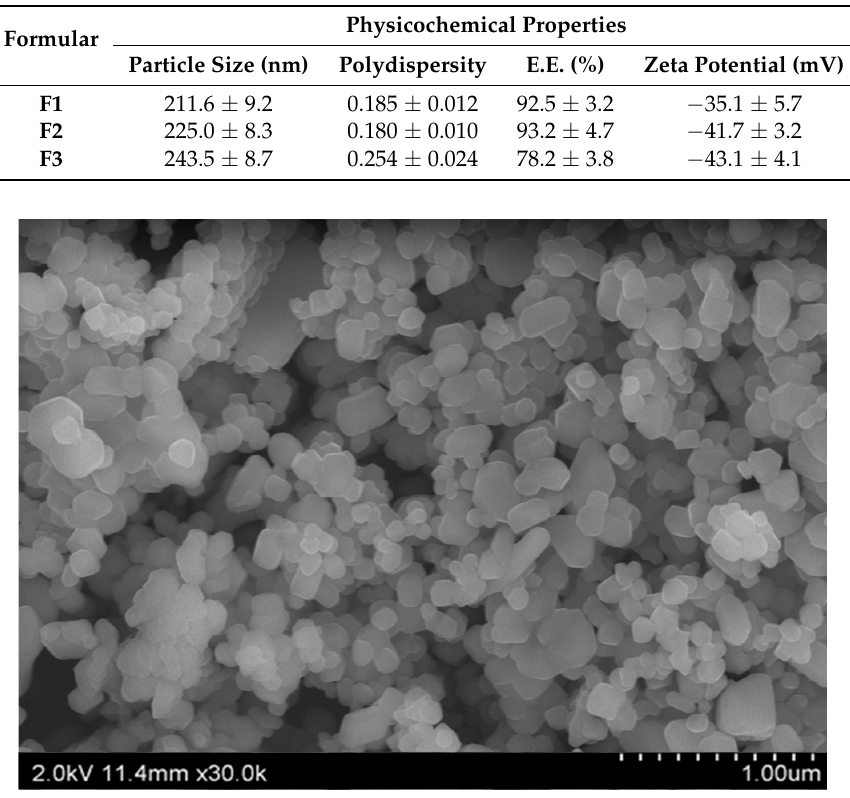
Figure 2. Scanning electronic microscopy (SEM) image of F2.